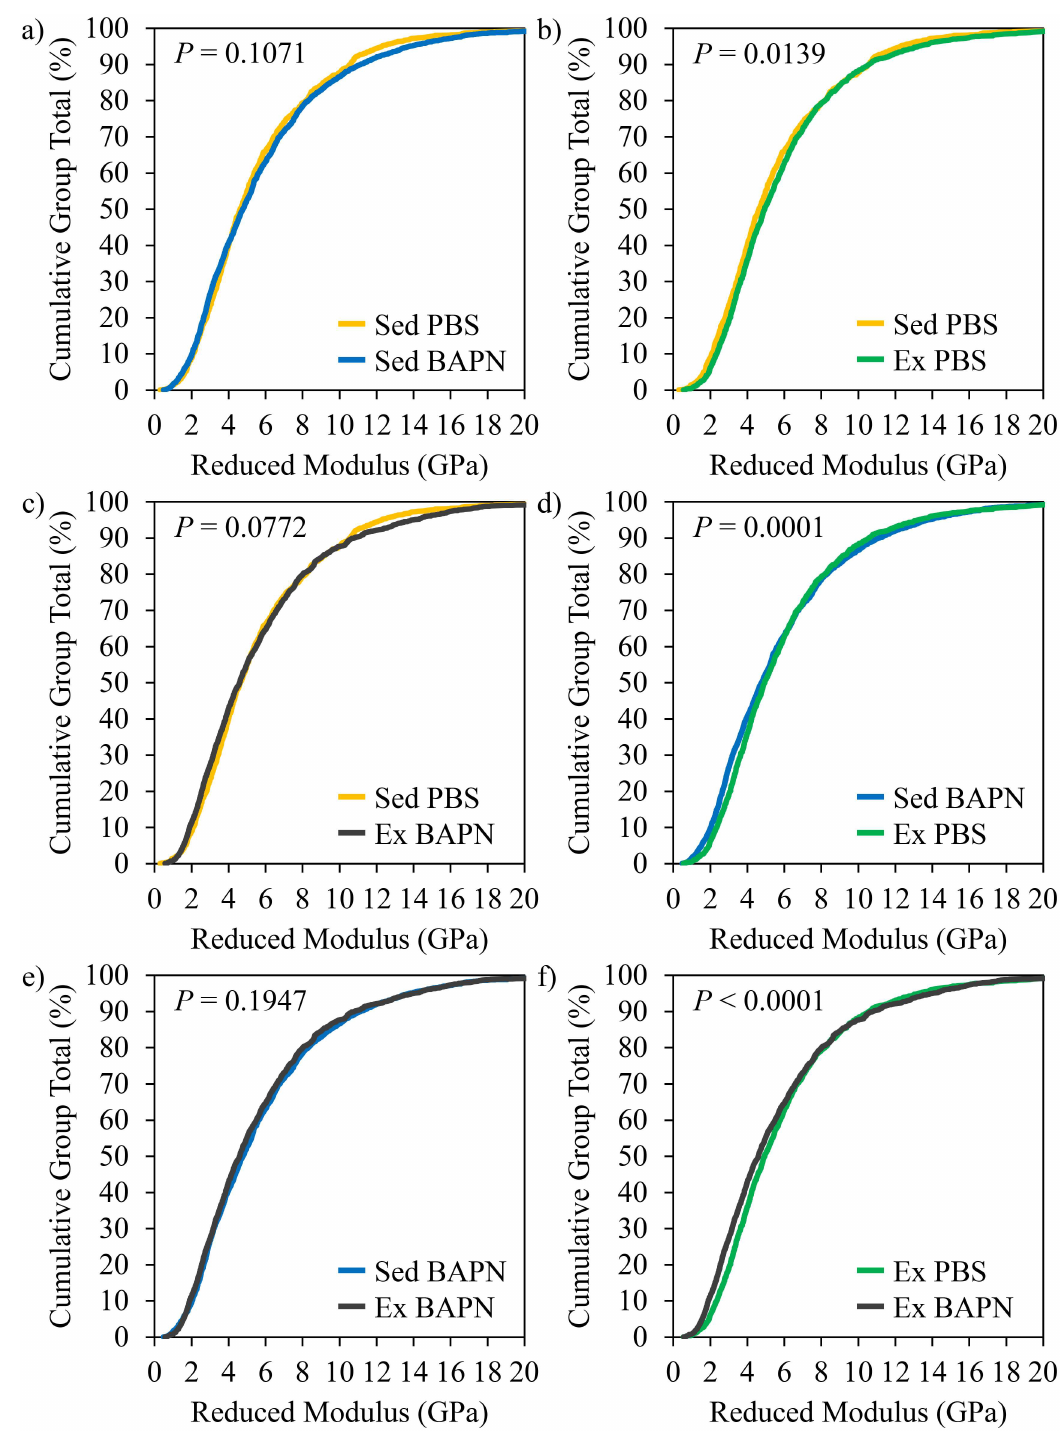
Fig 1. E r distributions. Pairwise comparisons of E r from nanoscaleindentation. a) Sed BAPN vs. Sed PBS. b) Ex PBS vs. Sed PBS. c) Ex BAPN vs. Sed PBS. d) Ex PBS vs. Sed BAPN. e) Ex BAPN vs. Sed BAPN. f) Ex BAPN vs. Ex PBS.